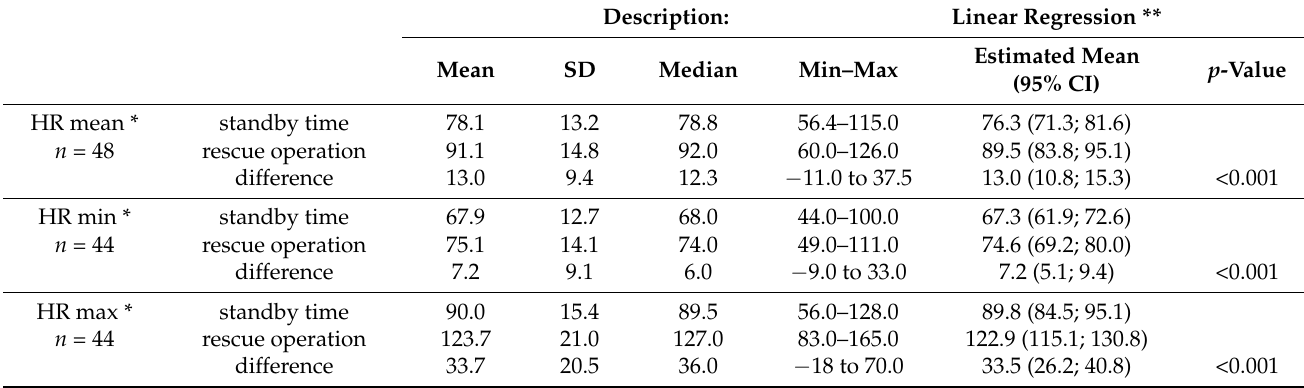
Table 3. Heart rate (HR max, HR min, HR mean) during rescue operations and in standby time.